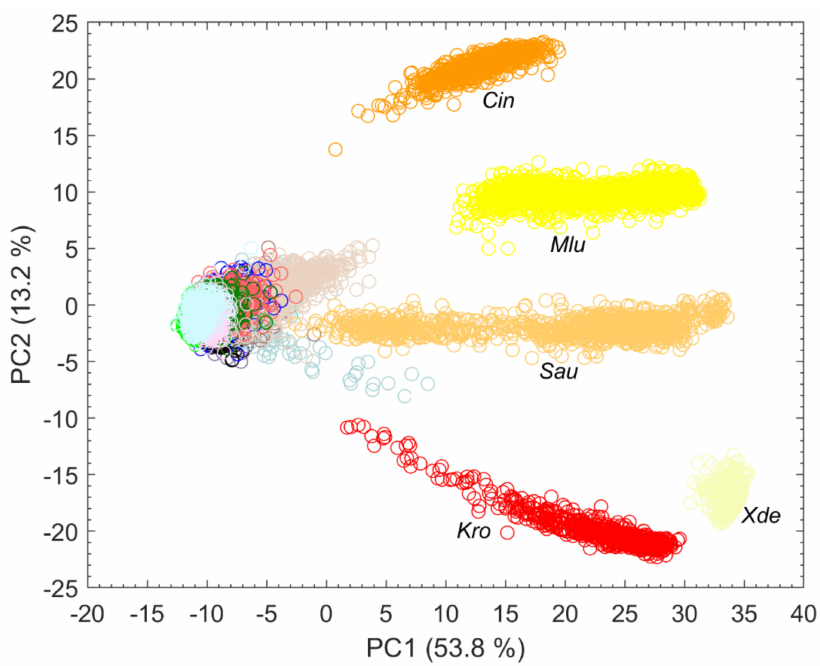
Figure 3. First two PCs of a PCA with explained variance in percent calculated with all spectra collected from microorganisms on the silver mirror slide ( n = 17,651) and species abbreviation below particularly strongly separated clusters.